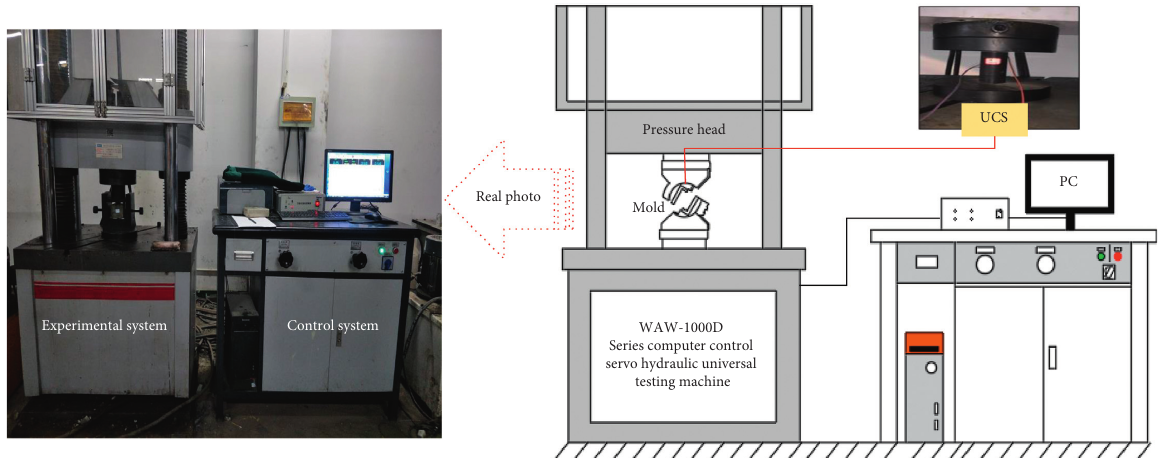
Figure 6: Mechanical performance testing and equipment.